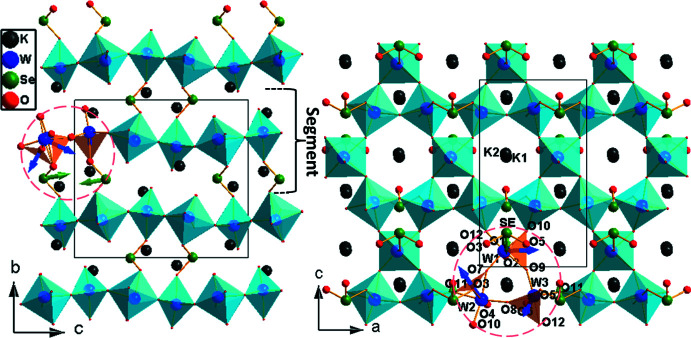
Polyhedral representation of (left) the unit-cell structure viewed along the −a axis and (right) a segment of the (W3SeO12)2− structure along with the K+ counter-cations, viewed along the −b axis, of K2W3SeO12 (4α). A W1W2W3O15 moiety with pyramidal selenium is indicated by a dashed red line and the net dipole directions of octa­hedral WO6 and pyramidal SeO3 are shown.